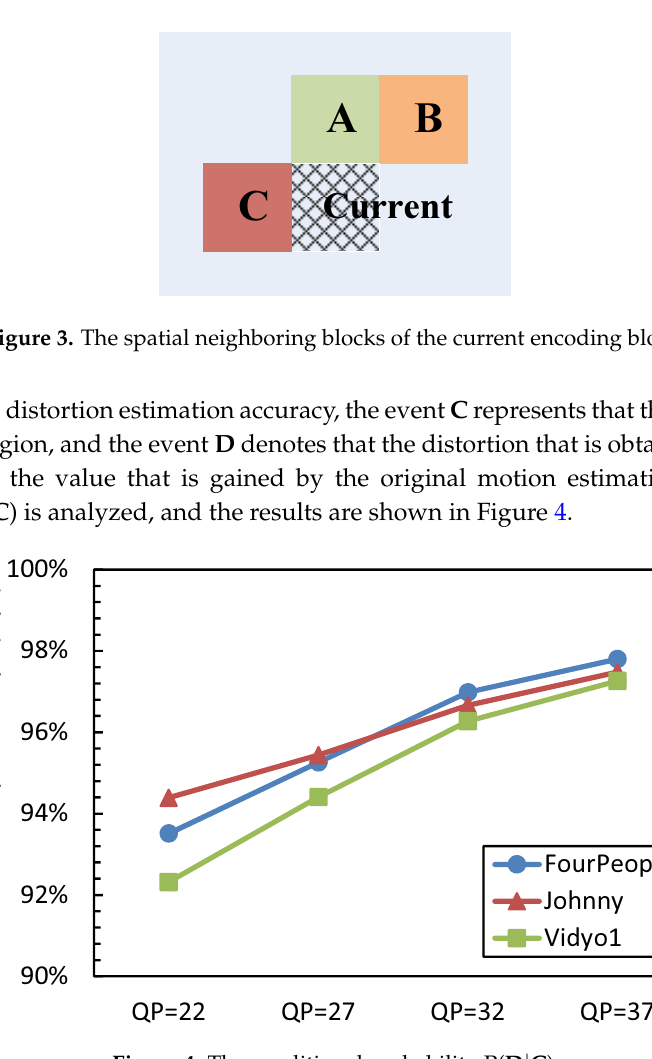
Figure 4. The conditional probability P( D | C